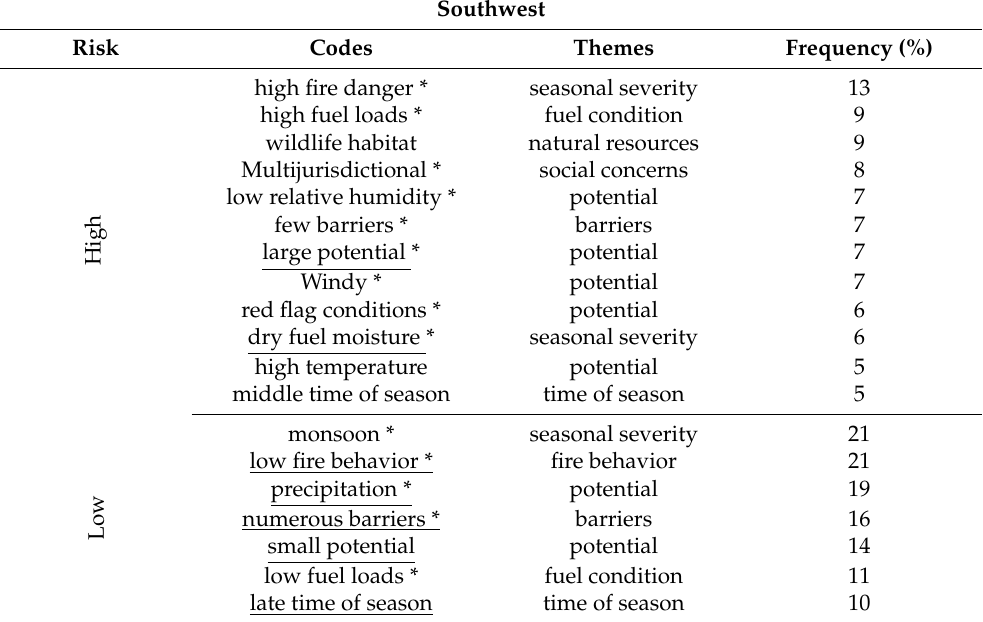
Table 4. Codes and associated themes that are more influential to distinguish high and low risk fires in the Southwest. Codes were included if they had a chi-square p -value < 0.05 and occurred with frequencies greater than or equal to 10% for low risk fires and 5% for high risk fires, ranked from most common to less common. An asterisk denotes p < 0.005. Underlined codes were common to both Geographic Areas